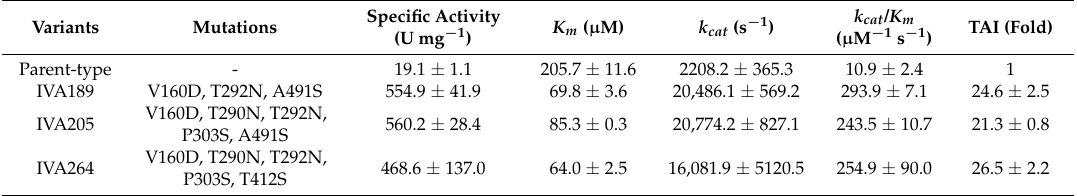
Table 2. Kinetics constants of evolved laccases from the laccase library after in vivo assembly at pH 4.0. Variants